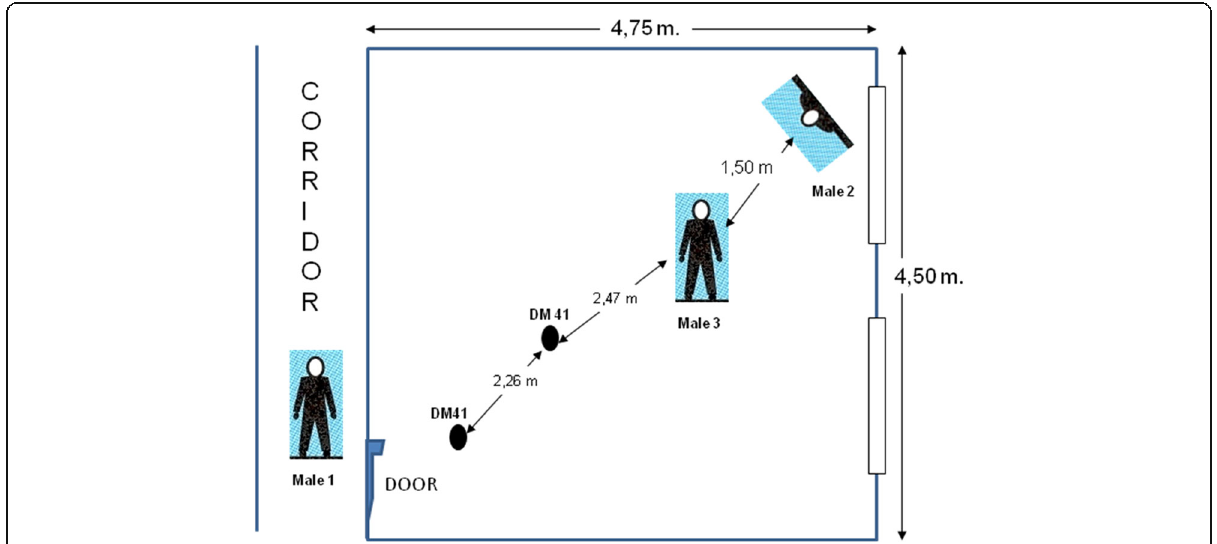
Fig. 1 Sketch of the case with two DM-41 hand grenades were detonated